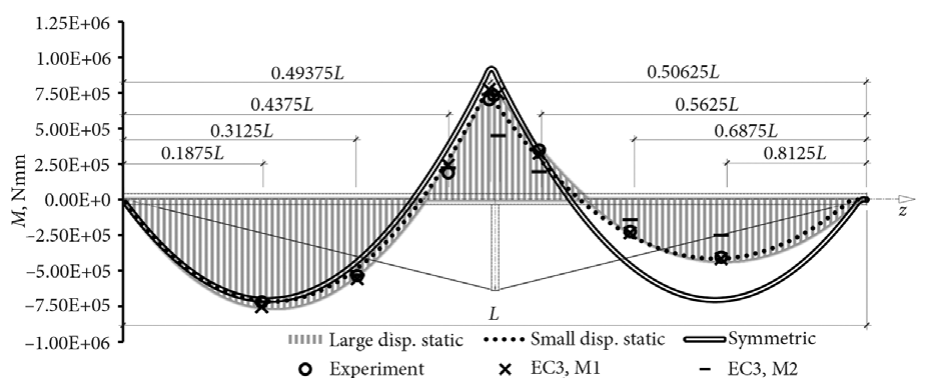
Fig. 9. Results of the UGB flexural response under Test C